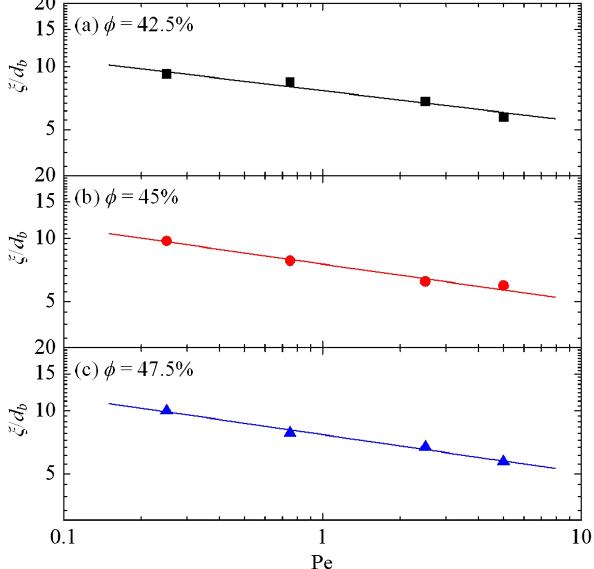
_ γη (solid symbols) and the FIG. 4. ξ ð Pe Þ in the shear-thinning regime. Symbols denote the M ¼ pb G ∞ γ (open symbols) in the simulatedresults.Lines denotethe fits withthe power law ξ ∝ Pe − ν . el ¼ NN 4 k T= 3 π d 3 . With this unit, 0 ¼ B b . sol Þ